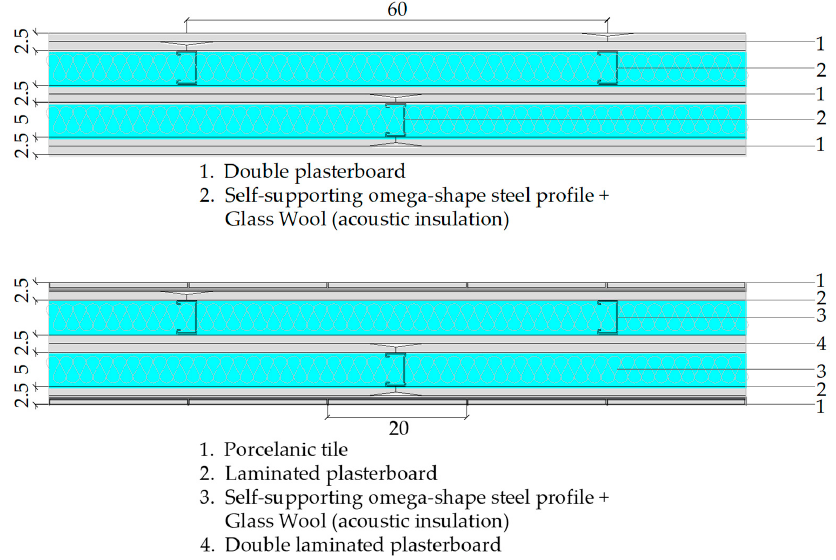
Figure A5. Median walls components detail.